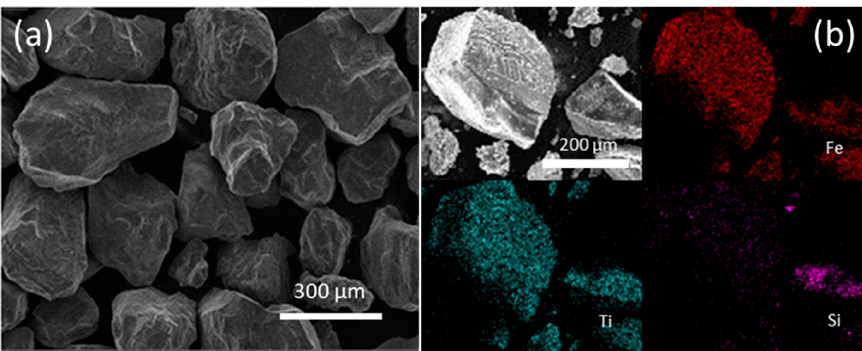
Figure 4. ( a ) SEM picture of ilmenite sample, ( b ) EDS mapping analysis of ilmenite sample.